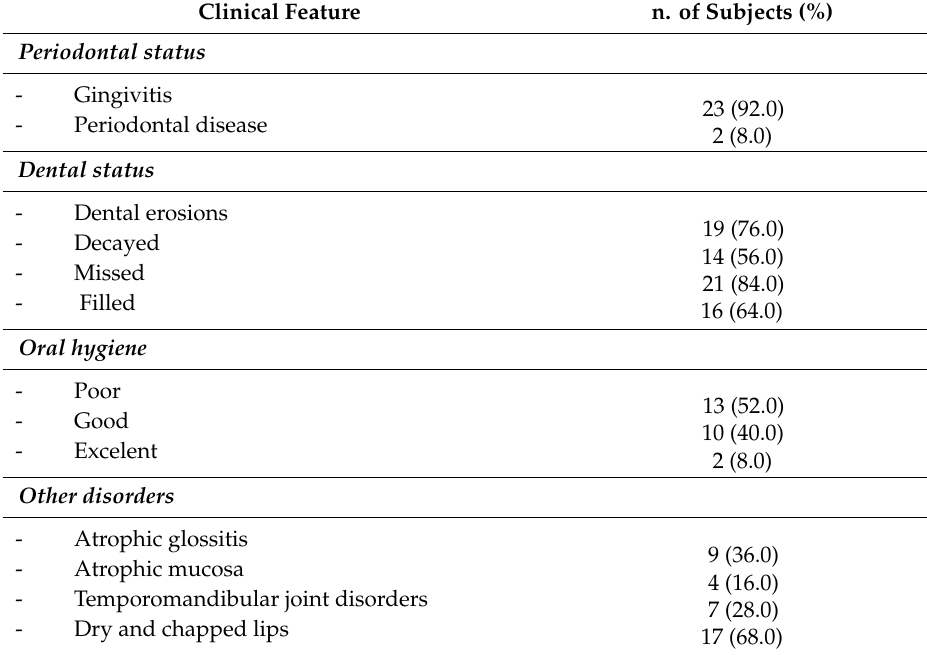
Table 1. Summary of oral and dental manifestations in anorexia nervosa (AN) patients. Clinical Feature n. of Subjects (%)